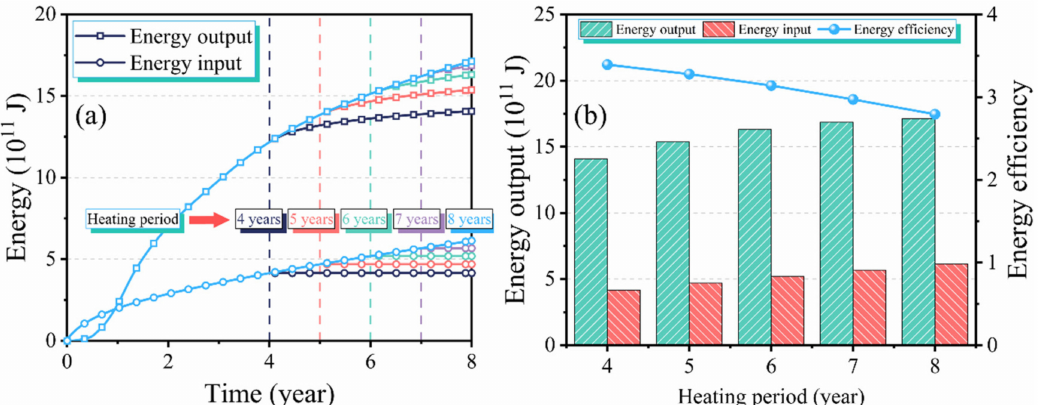
Figure 13. Effects of the heating period on: ( a ) input and output energy evolution; ( b ) cumulative input energy, output energy and energy